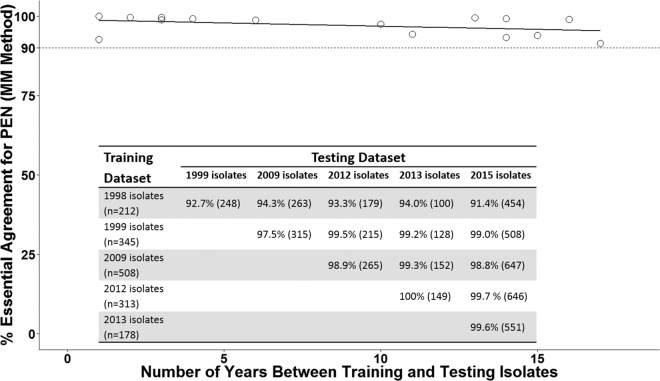
Regression line showing the effect of time between the training and testing data sets on percent essential agreement (EA). Isolates in one of the surveillance years 1998, 1999, 2009, 2012, and 2013 were used as the training data set for the MM model to predict PEN MIC for isolates in subsequent years with trained PBP types. The inset table shows percent EA (number of isolates used to calculate EA) in the indicated testing data set. Based on data in the table, the year-specific percent EA was plotted against separation time between the training and testing data sets (open circles). A fitted linear regression line is shown (solid line).